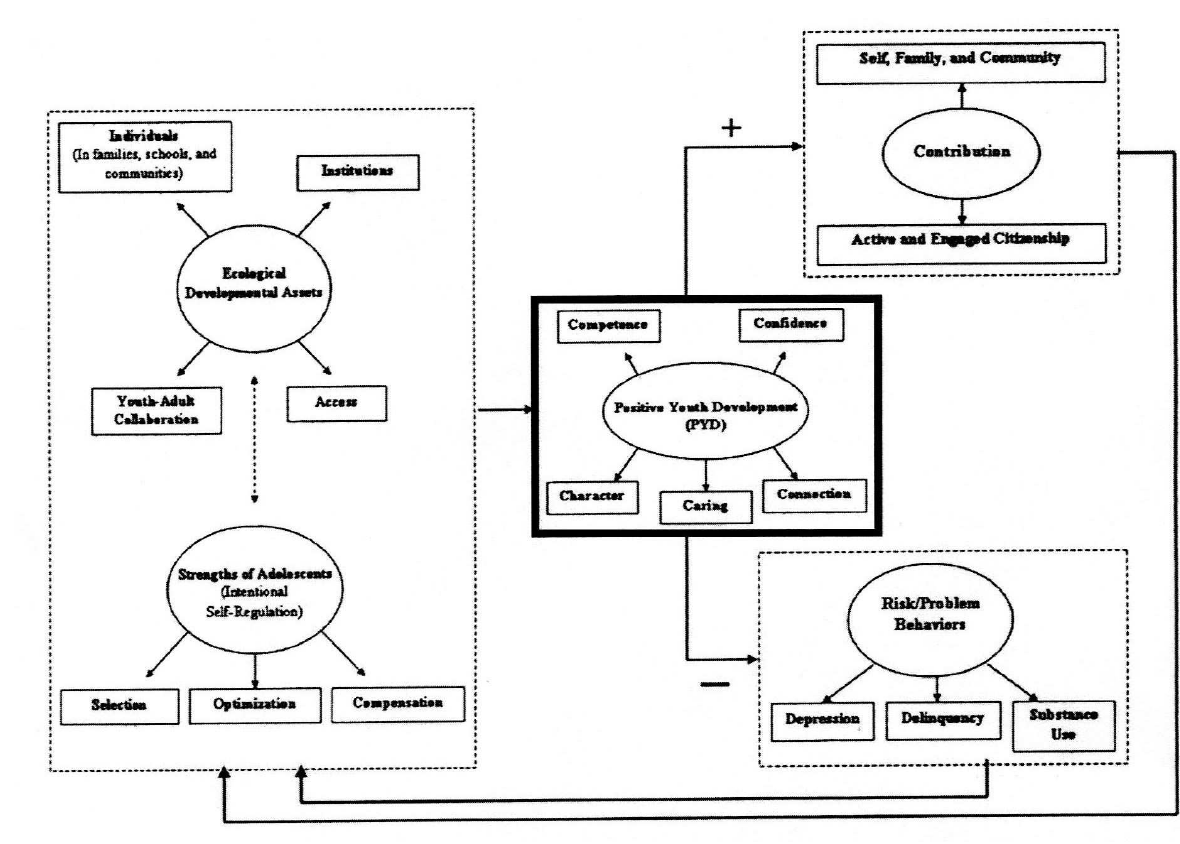
Figure 1. A Developmental Systems Theory-Based Framework of Thriving in Adolescence. Adapted from “Special issue introduction: The meaning and measurement of thriving: A view of the issues,” by R.M. Lerner, A. von Eye, J.V. Lerner, S. Lewin-Bizan, and E.P. Bowers, 2010, Journal of Youth and Adolescence, 39, p. 712. Copyright 2010 by Springer Science+Business